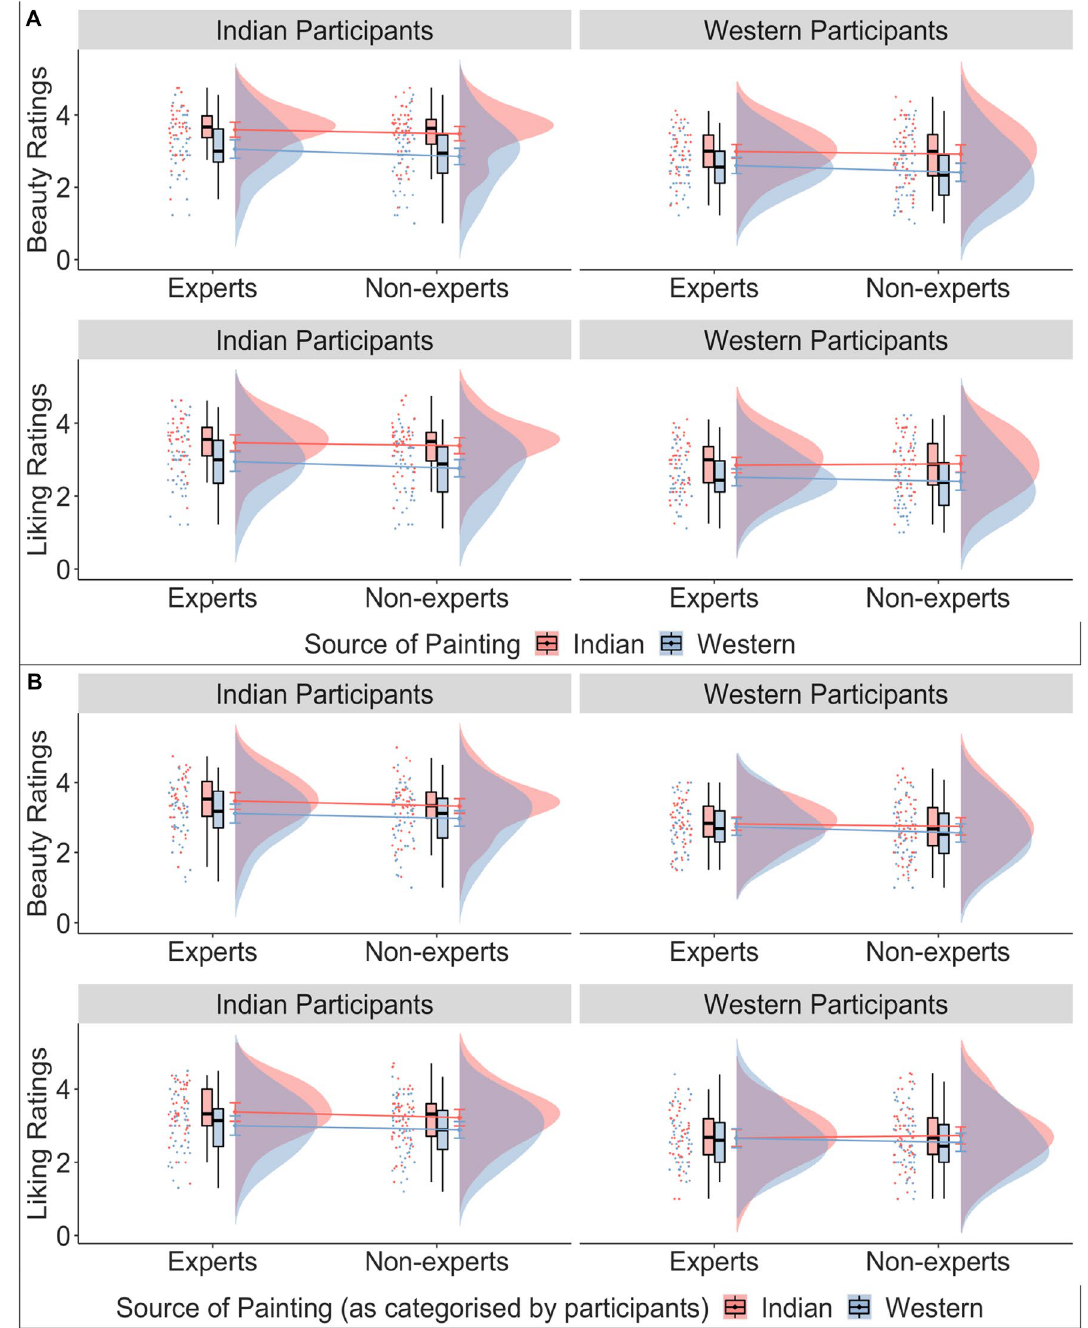
Figure 7. The effect of source of painting (A) and the source of painting as categorized by participants (B; Indian or Western paintings depicted in red and blue respectively), expertise (art experts or non-experts) and culture (Indian participants or Western participants) on the ratings of beauty and